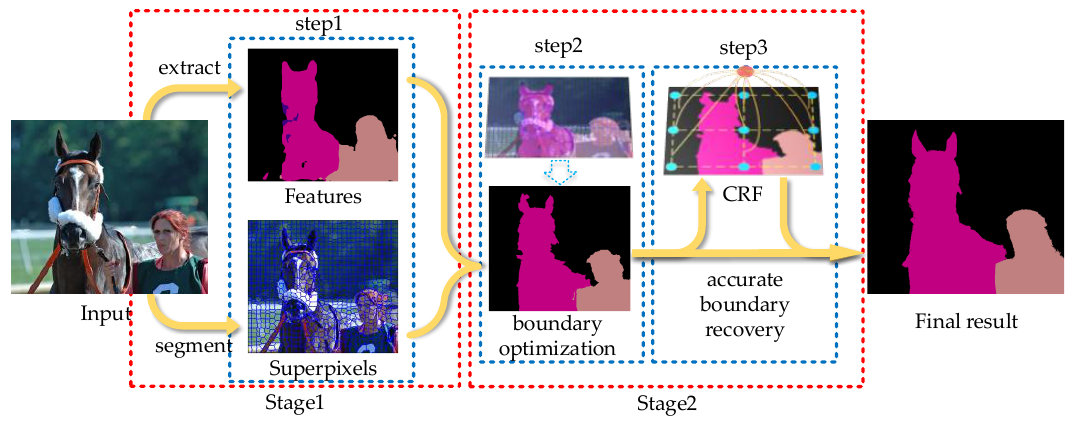
Figure 1. The flow chart of the proposed method.